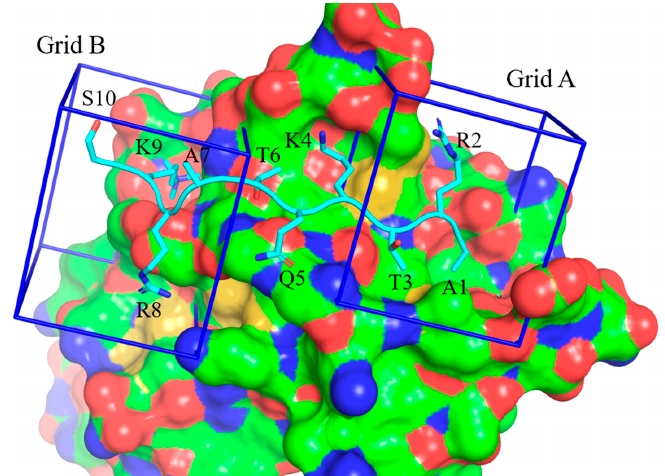
Figure 3. Histone H3 bound to ATRX ADD with the docking sites highlighted (Modified from PDB ID 3QLA). Surface colors: red = negatively charged surface area; blue = positively charged surface area; green = hydrophobic; yellow = methionine (sulfur).